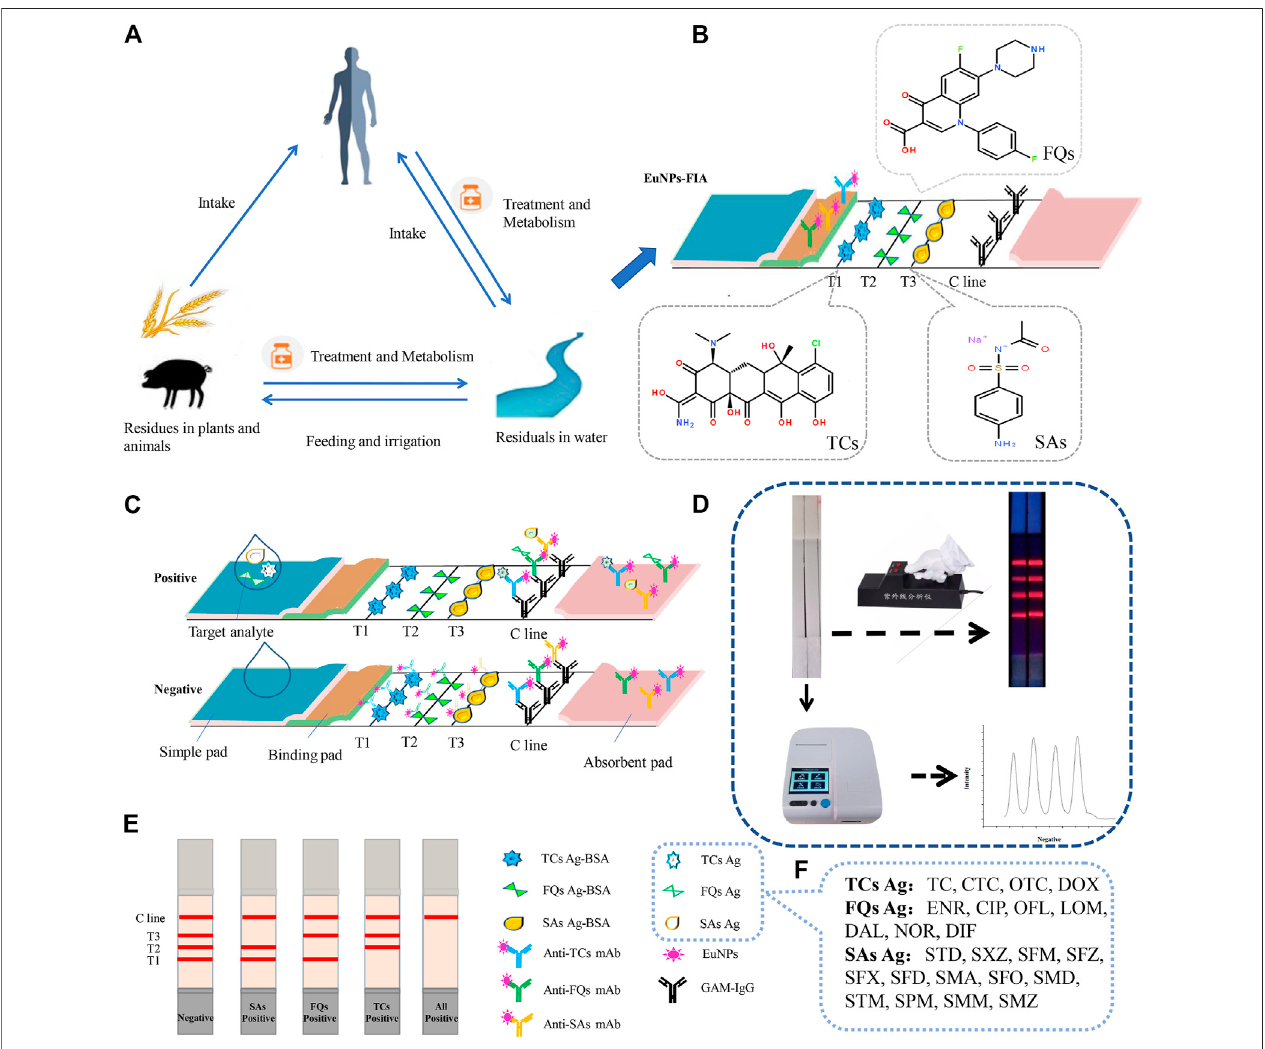
FIGURE 1 | The EuNPs-FIA detection principle. (A) The cycle of antibiotics between man and nature. (B) Principle of assemble EuNPs-FIA test strips. (C) Test results of the EuNPs-FIA reader test results. (D) The actual testing process and test results of the EuNPs-FIA reader test results. (E) Diagram of the test results. (F) Number of detectable target